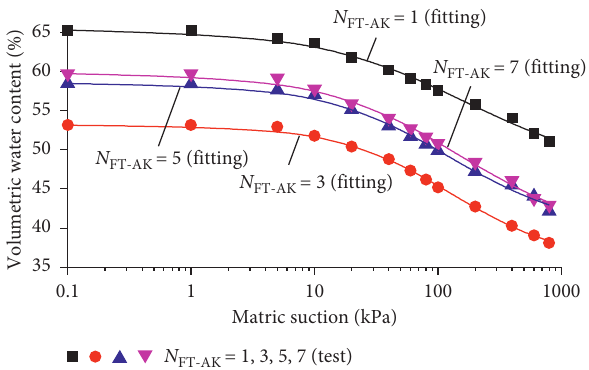
Figure 15: The fitting curves using Gardner model under different times of freeze-thaw cycle for AK expansive soil.